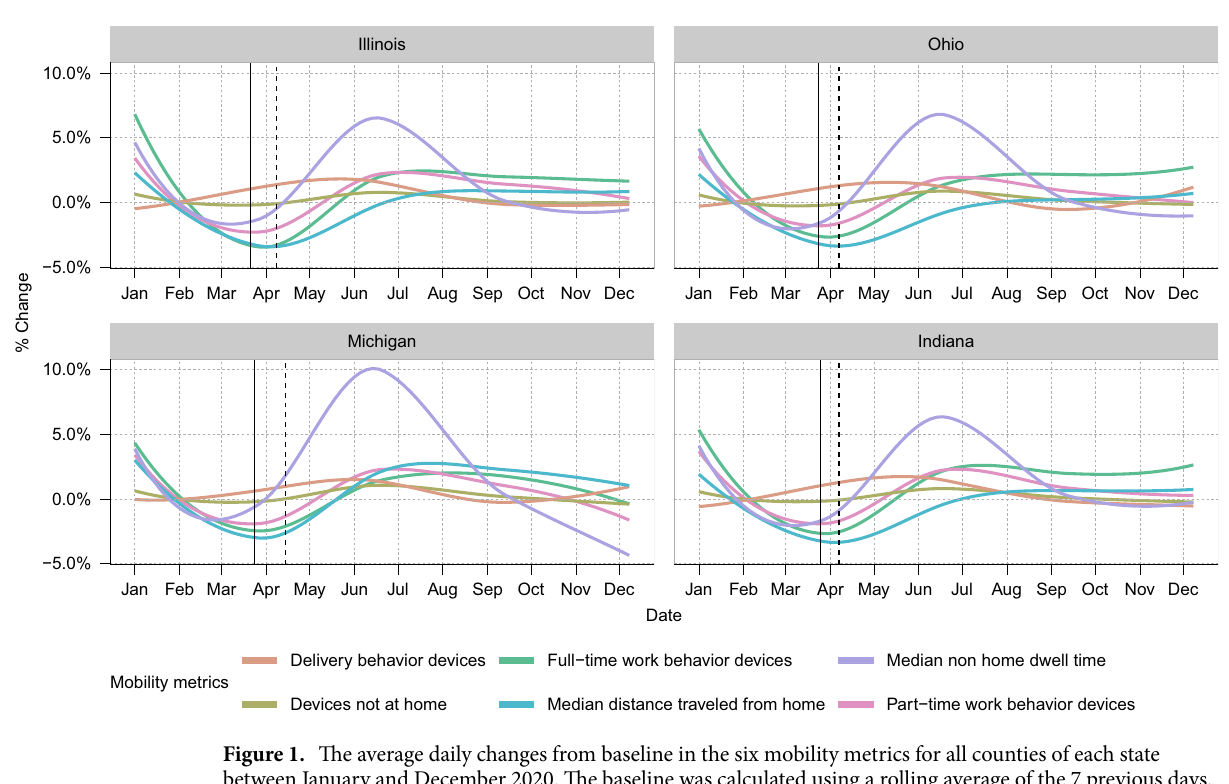
b Based on the 2020 Presidential elections 48 .